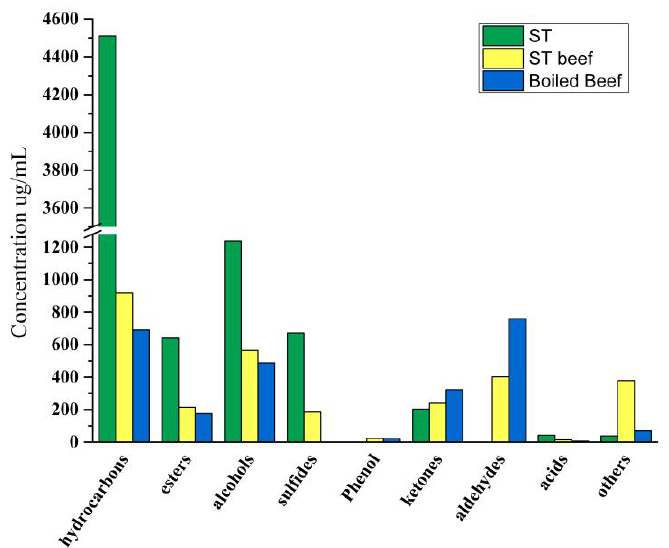
Figure 5. Changes in volatile compounds content in ST, ST beef, boiled beef.